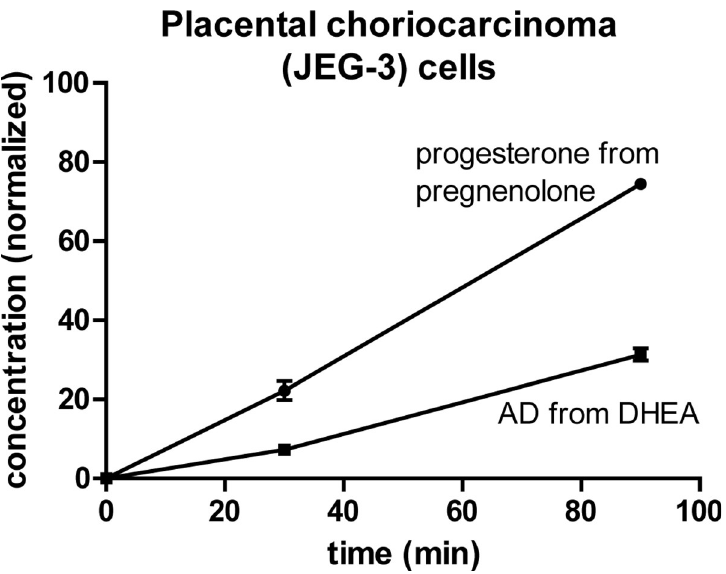
Fig 5. Uptake of pregnenolone and conversion to progesterone are faster than uptake of DHEA and conversion to AD. Normalized concentrations (mean ± SD) over time of progesterone and AD after JEG-3 cells were treated in parallel with 100 nM pregnenolone or DHEA. Results from one representative experiment with biological triplicates are shown; similar results were obtained in a second experiment.